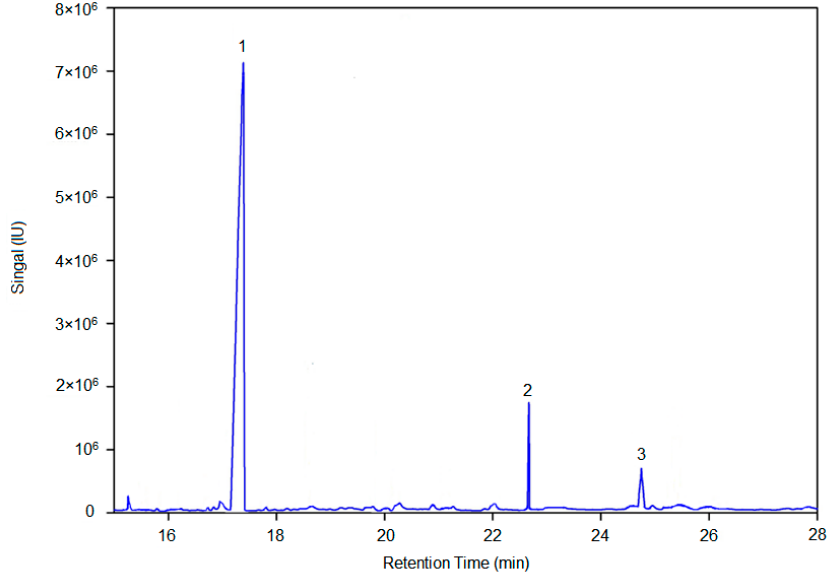
Figure 5. GC-MS total-ion chromatogram of AX-I-3b methylation. Table 1. Results of methylation analysis of AX-I-3b.